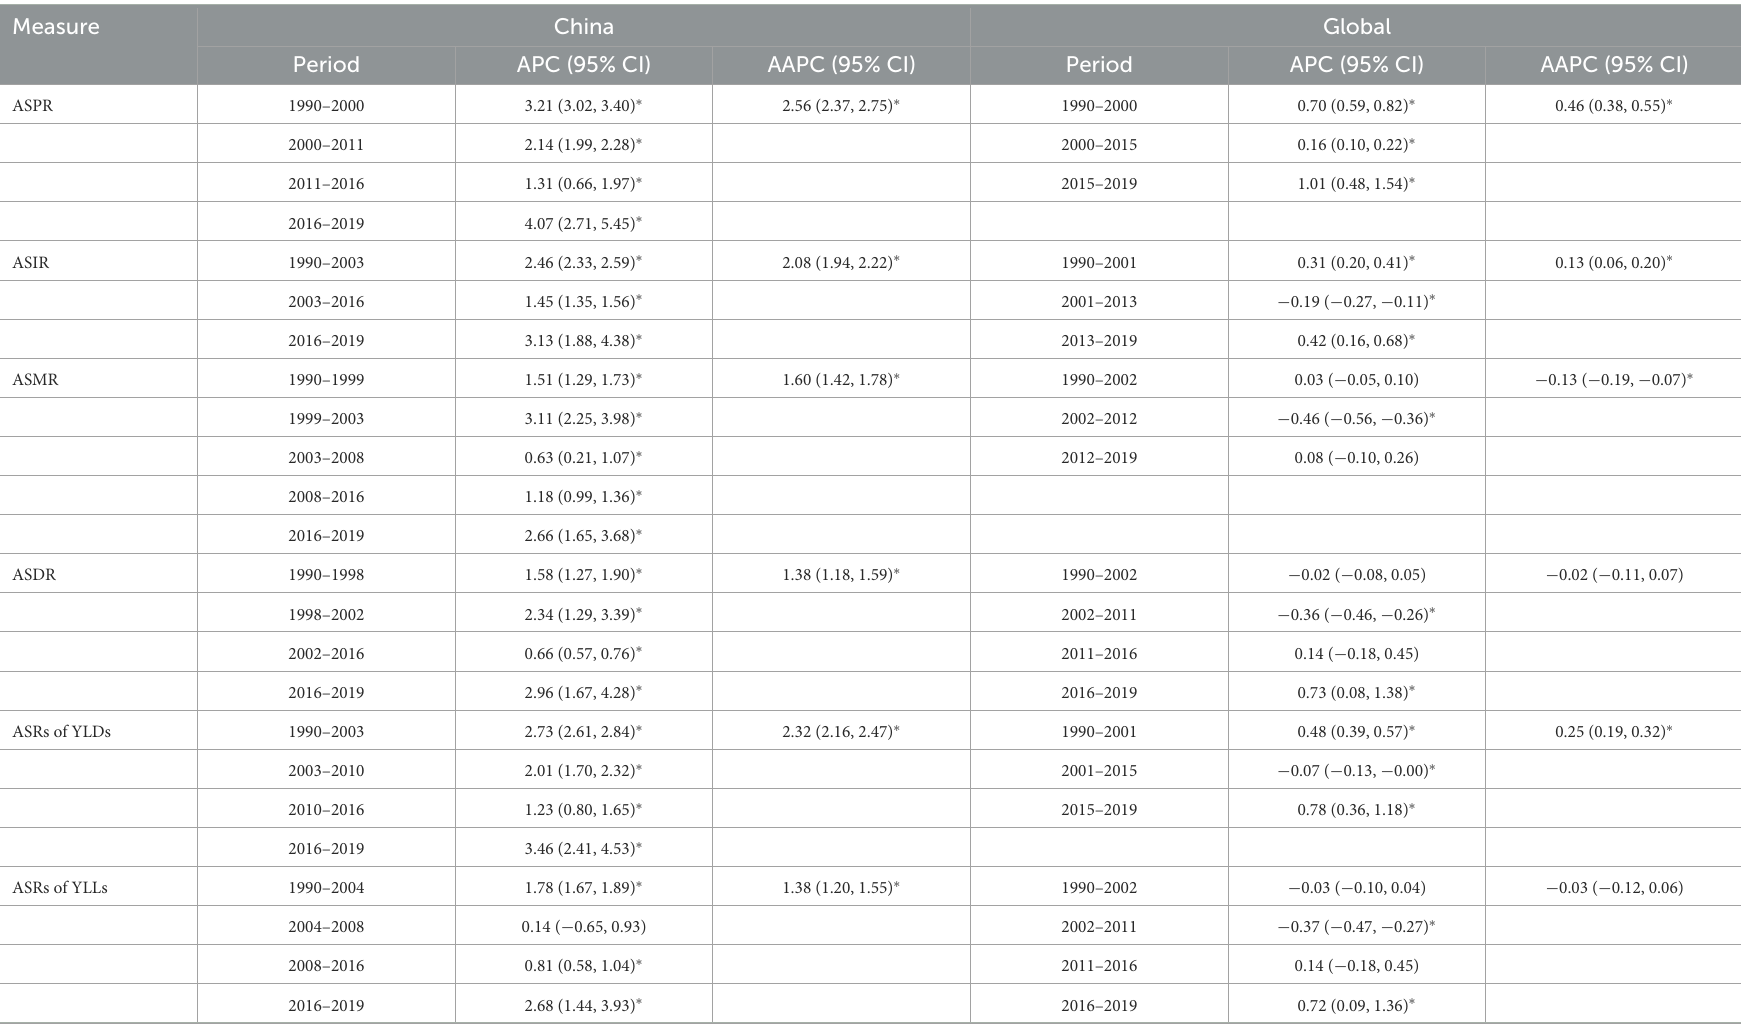
TABLE 2 Joinpoint regression analysis: trends in age-standardized rates of incidence, prevalence, mortality, DALYs, YLDs, and YLLs (per 100,000 population) in China and Global level from 1990 to 2019. Measure China Global Period APC (95%